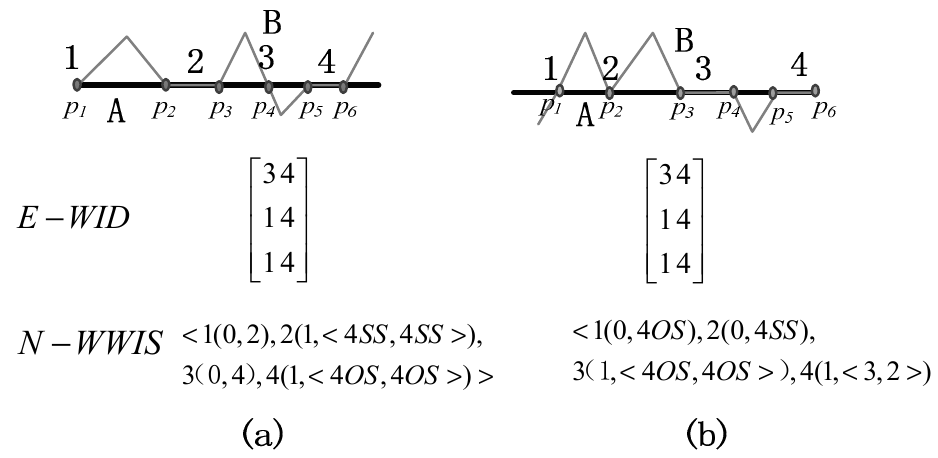
Figure 16. The refined relations between two lines in two examples that cannot be distinguished by the E-WID model but can be distinguished by the N-WWIS model. ( a ) One case that the intersection components between line A and line B are two intersection-lines and two intersection-point; ( b ) The other case that the intersection components between line A and line B are two intersection-lines and two intersection-point.